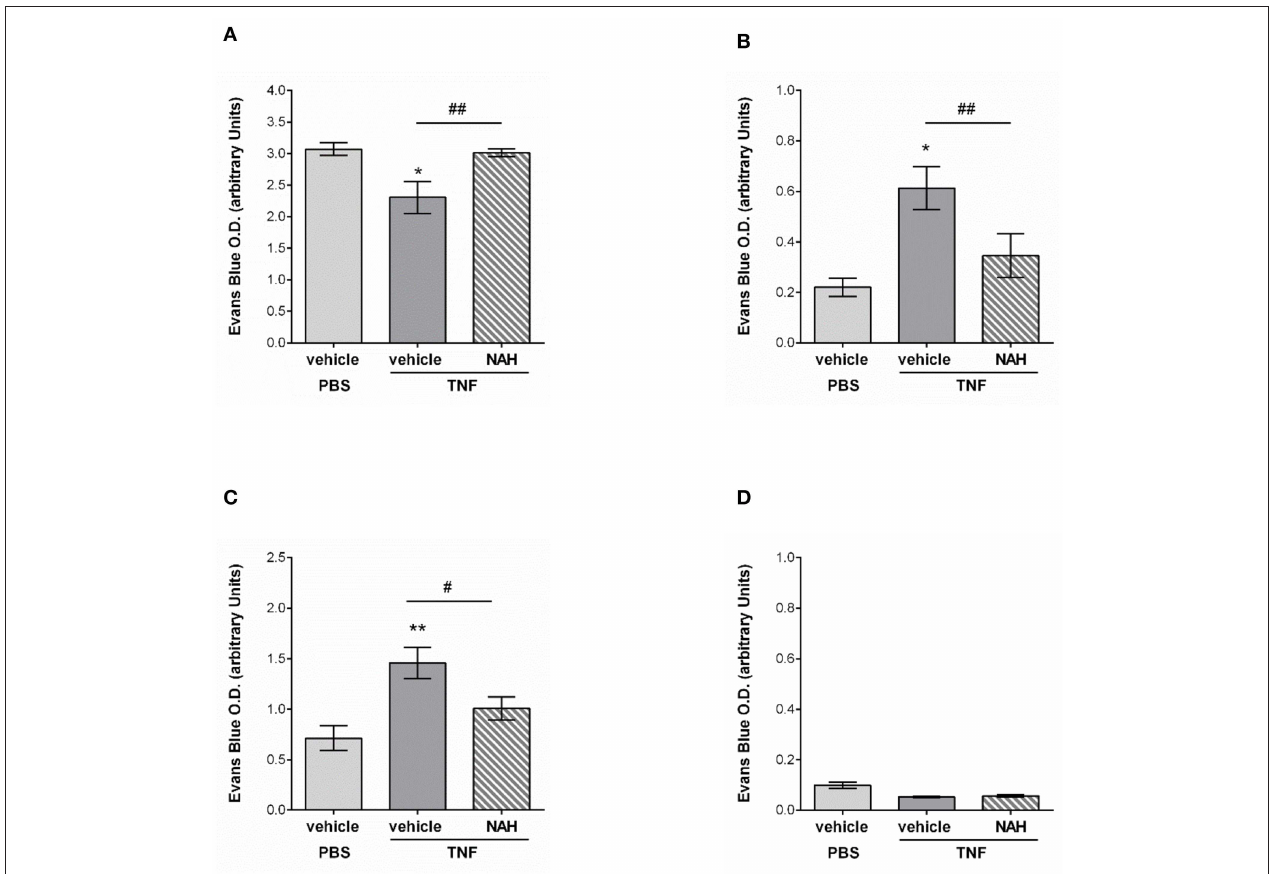
FIGURE 9 | Effect of a non-anticoagulant heparanase inhibitor (NAH) on lymphatic drainage in TNF-stimulated tissues. TNF (300 ng) or PBS (as control) were administrated intrascrotally. Three hours later, mice received an i.s. injection of 50 µ g of non-anticoagulant heparanase inhibitor N-desulfated/re-N-acetylated heparin (NAH) or vehicle. Twenty min before the end of the inflammatory period (i.e., 16h), mice received an i.s. injection of 1% Evans Blue. Animals were then sacrificed, their plasma, cremaster tissues, draining, and non-draining lymph nodes were collected and prepared for spectrophotometric analysis of Evans Blue content. (A) Quantification of the Evans Blue content in the mouse cremaster ( N = 6–10 mice per group). (B) Quantification of the Evans Blue content in draining lymph (i.e., inguinal) nodes of the cremaster muscles ( N = 6–7 mice per group). (C) Quantification of the Evans Blue content in mouse plasma samples ( N = 6–10 mice per group). (D) Quantification of the Evans Blue content in non-draining (i.e., brachial) lymph nodes ( N = 4 mice per group). Statistical significance between PBS and TNF stimulated groups are indicated by asterisks: * P < 0.05, ** P < 0.01. Statistical significance between vehicle and NAH-treated groups are indicated by hash symbol: # P < 0.05, ## P <